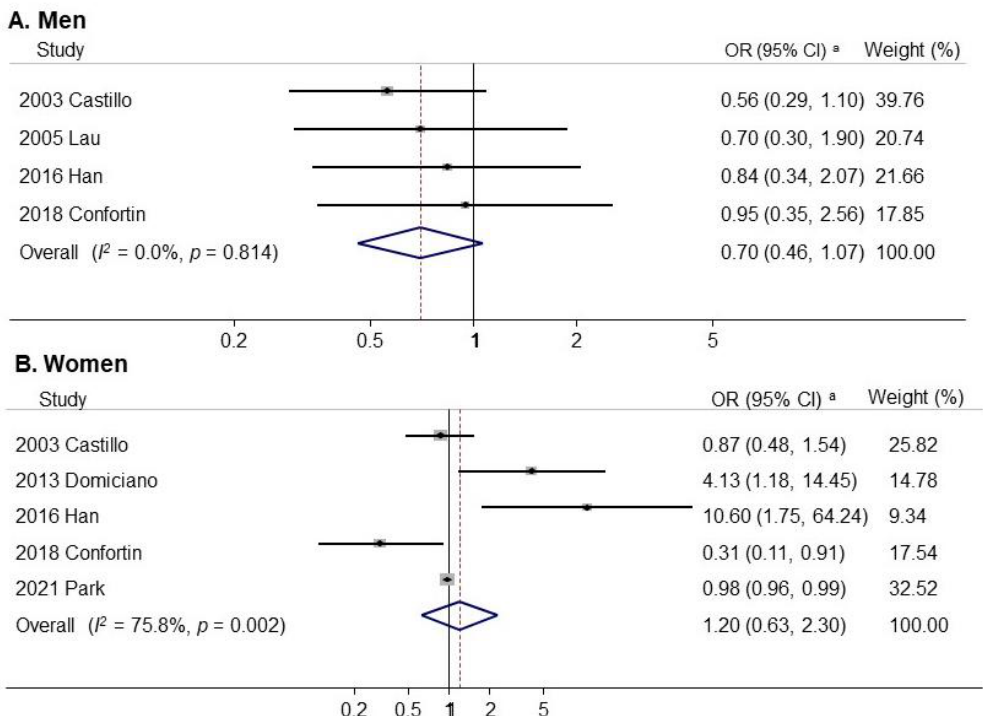
Figure 3. Meta-analysis of the association between sarcopenia and alcohol consumption by sex. ( A ) subgroup analysis by men; ( B ) subgroup analysis by women. a Random effects model. Abbreviation: OR, Odd Ratio; CI, Confidence Interval [20,27,28,31,34,38].